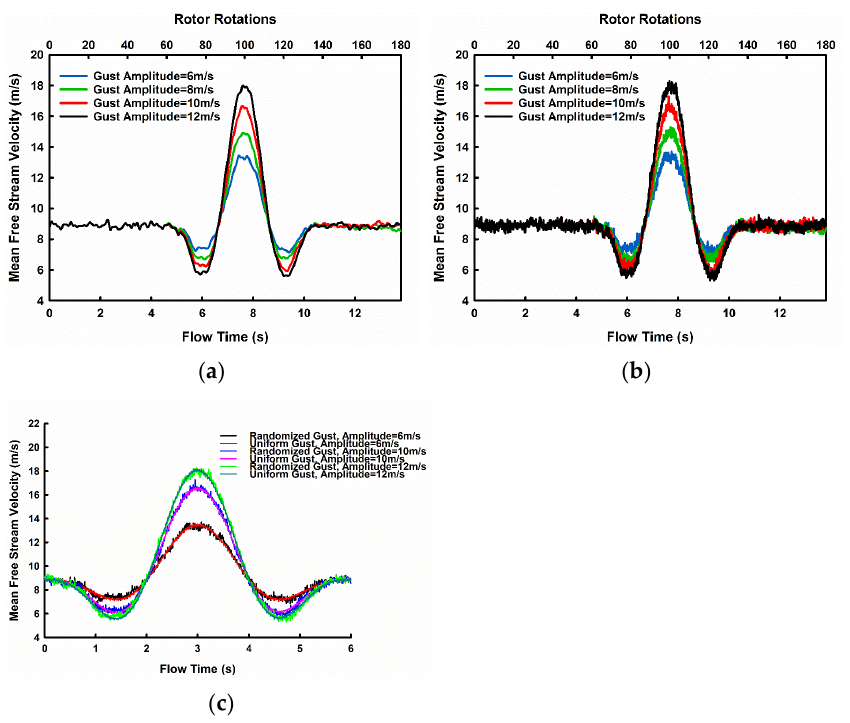
Figure 17. ( a ) The variation in cycle-averaged U∞ for Ugust = 6 m/s, 8 m/s, 10 m/s and 12 m/s; ( b ) Instantaneous variation of U∞ for Ugust = 6 m/s, 8 m/s, 10 m/s and 12 m/s; ( c ) Comparison of Randomised Gust velocity and Uniform gust velocity. The magnitude of randomised fluctuation is 6 m/s. The continuous spikes in the velocity profile subsequently affect the C p values of the wind turbine. Figure 18a shows the variation of cycle-averaged λ for various randomised U gust cases. The minimum fluctuation of λ occurs for U gust = 6 m/s case with maximum and minimum values of λ being 4.89 and 2.84, respectively. The maximum fluctuation occurs in U gust = 12 m/s with maximum and minimum values of λ values at 6.04 and 2.18, respectively. Figure 18b represents the instantaneous randomised λ values for the four gust cases taken at every 20 timesteps.